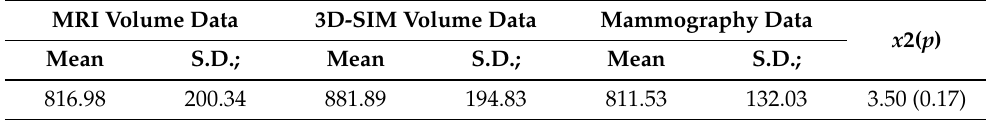
Table 9. Paired samples t-test of breast volume data (unit = cm 3